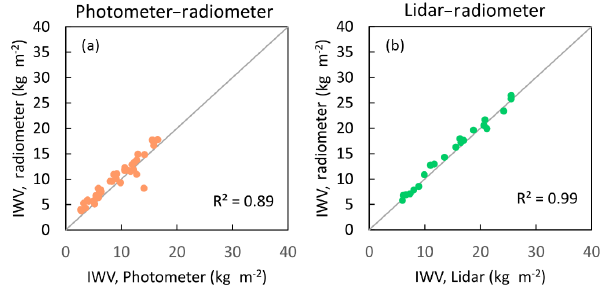
Figure 2. IWV intercomparison between different instruments: radiometer–sun photometer (a) and radiometer–lidar (b) with the R 2 coefficients